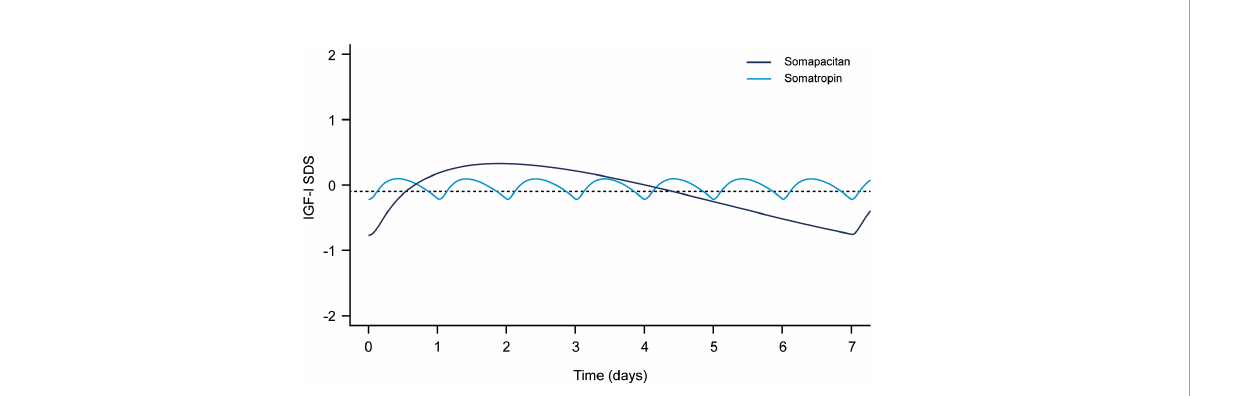
FIGURE 1 Simulated weekly IGF-I SDS levels following dosing with somapacitan (weekly GH [mean dose 2.4 mg]) and somatropin (daily GH [mean dose 0.3 mg]). Dashed line is weekly average IGF-I SDS for somapacitan (-0.09 SDS). Reproduced from Bentz Damholt et al. (24) under the CC BY- NC license